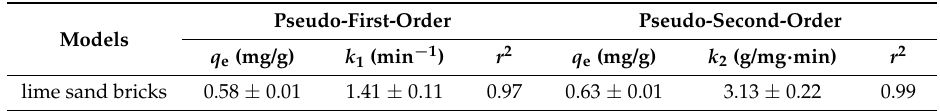
Table 3. The parameters deduced by pseudo-first and pseudo-second-order models for the adsorption of Cu(II) by lime sand bricks.